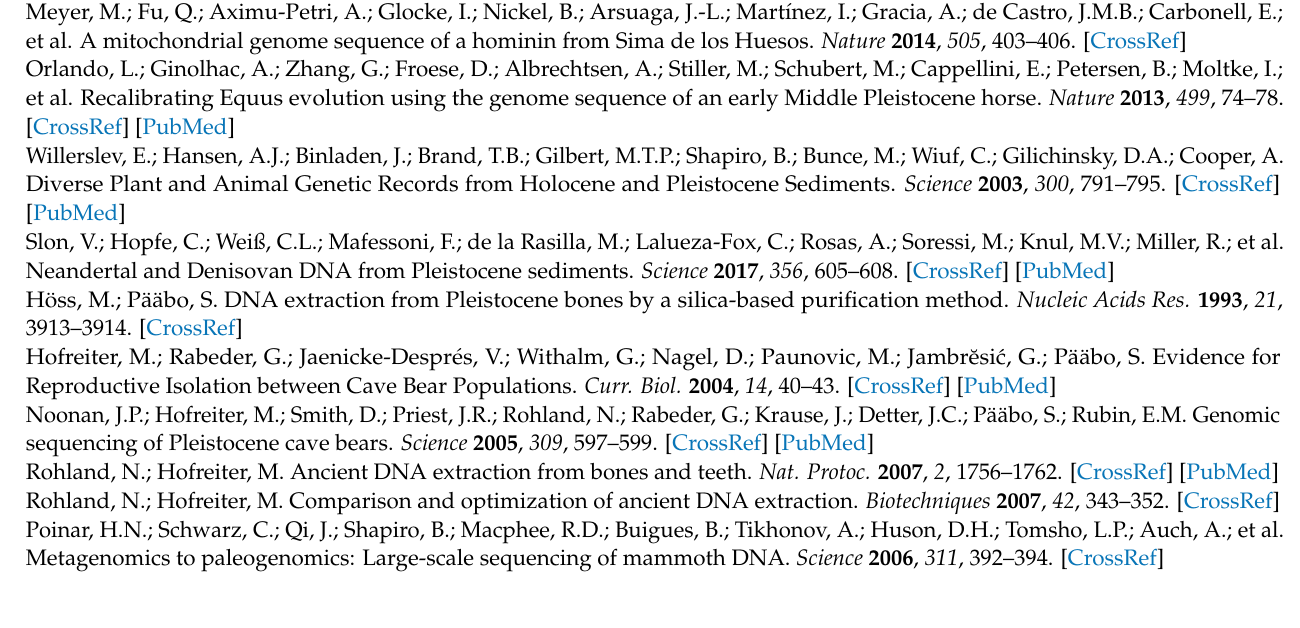
analyses, Table S3: Linear regression coefficients and slope comparison statistics, Table S4: Direct comparison between methods using 50 mg of bone powder and the ratios between Lor-500 mg and Dab-50 mg quantification values, Table S5: Degradation index obtained by dividing the results of mt69bp for the mt143bp quantification targets, Table S6: Average read depth for the control region and all mtGenome, percentage of covered mtGenome with at least 3 × and 5 × reads and normalized by milligram of bone powder used per extraction trial and sample tested, Table S7: Informative and total sequence content normalized to the best method, Table S8: Pairwise Wicoxon test between sample B extraction trials considering damage pattern and read positions separately (beginning or inside). Orange colored cells represent tests below p -value = 0.05 and Table S9: Haplotypes,